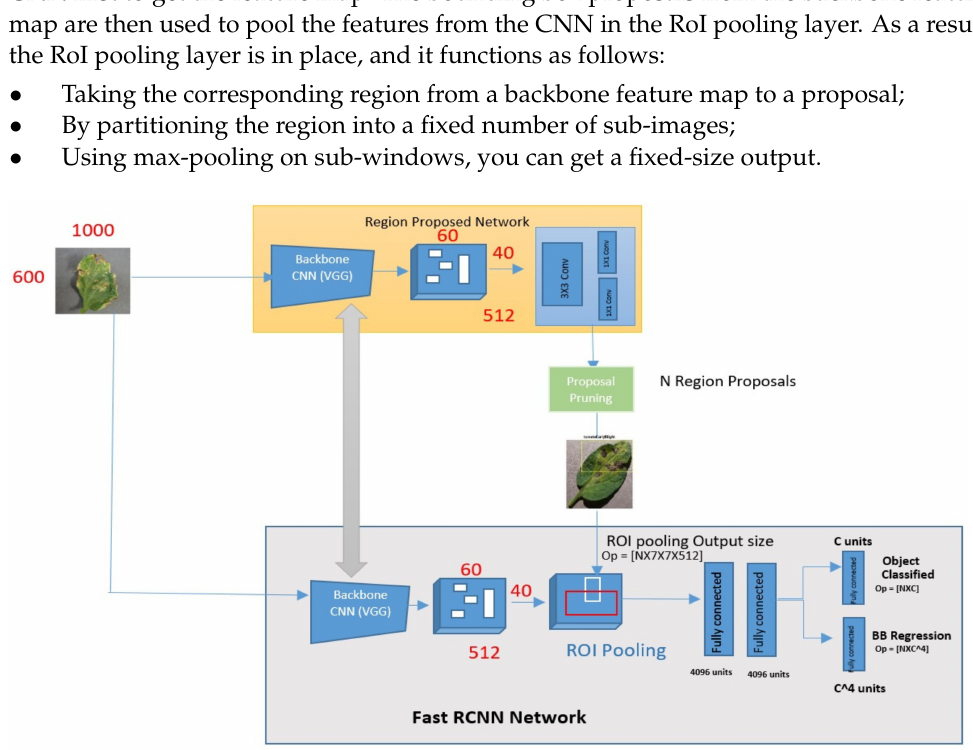
Figure 8. Faster R-CNN detector